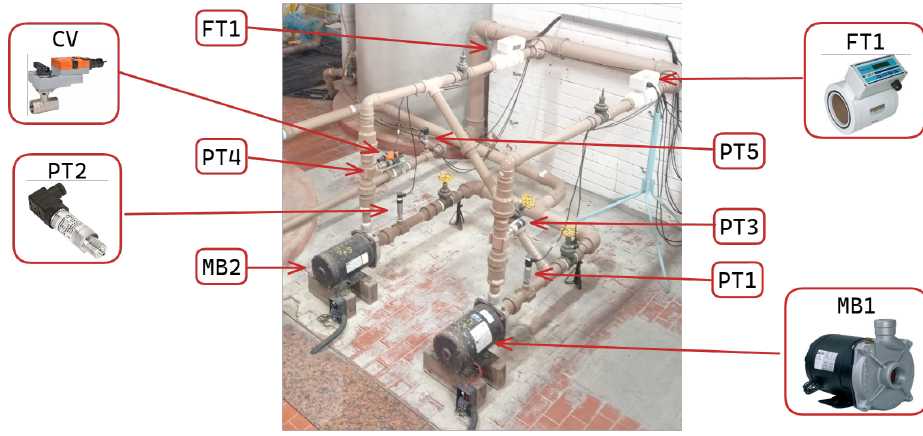
Figure 1. Experimental setup.